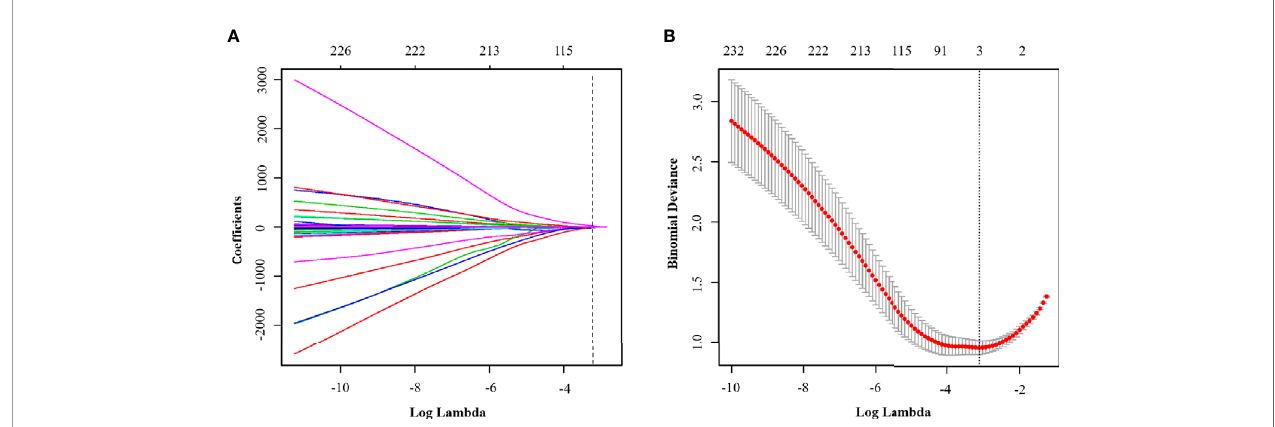
FIGURE 4 | (A) LASSO coef fi cient pro fi les of the clinical parameters in Model R . (B) Binomial deviance pro fi les of the texture features in Model R . According to the 1 standard error of the minimum criteria (the 1-SE criteria), a log( l ) value of − 3.107 was chosen (10-fold cross-validation, 1-SE